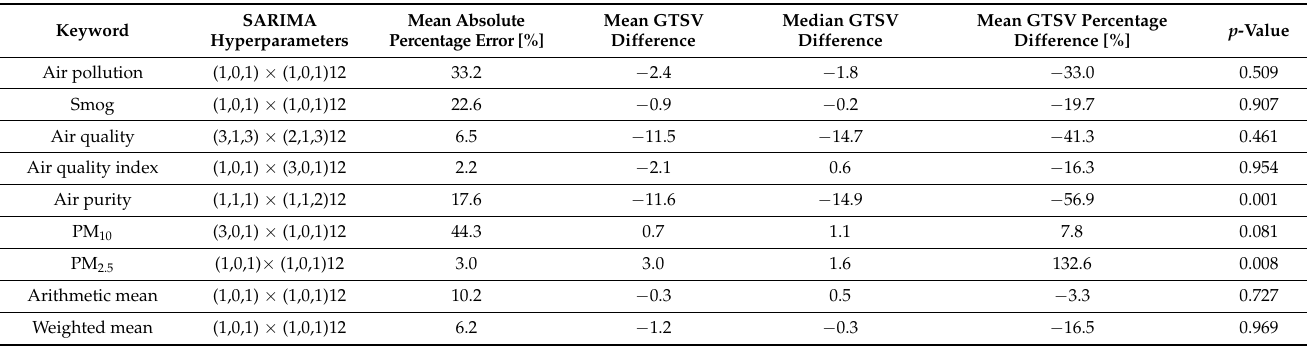
Table 3. Comparison of the forecasted and real-world intra-pandemic